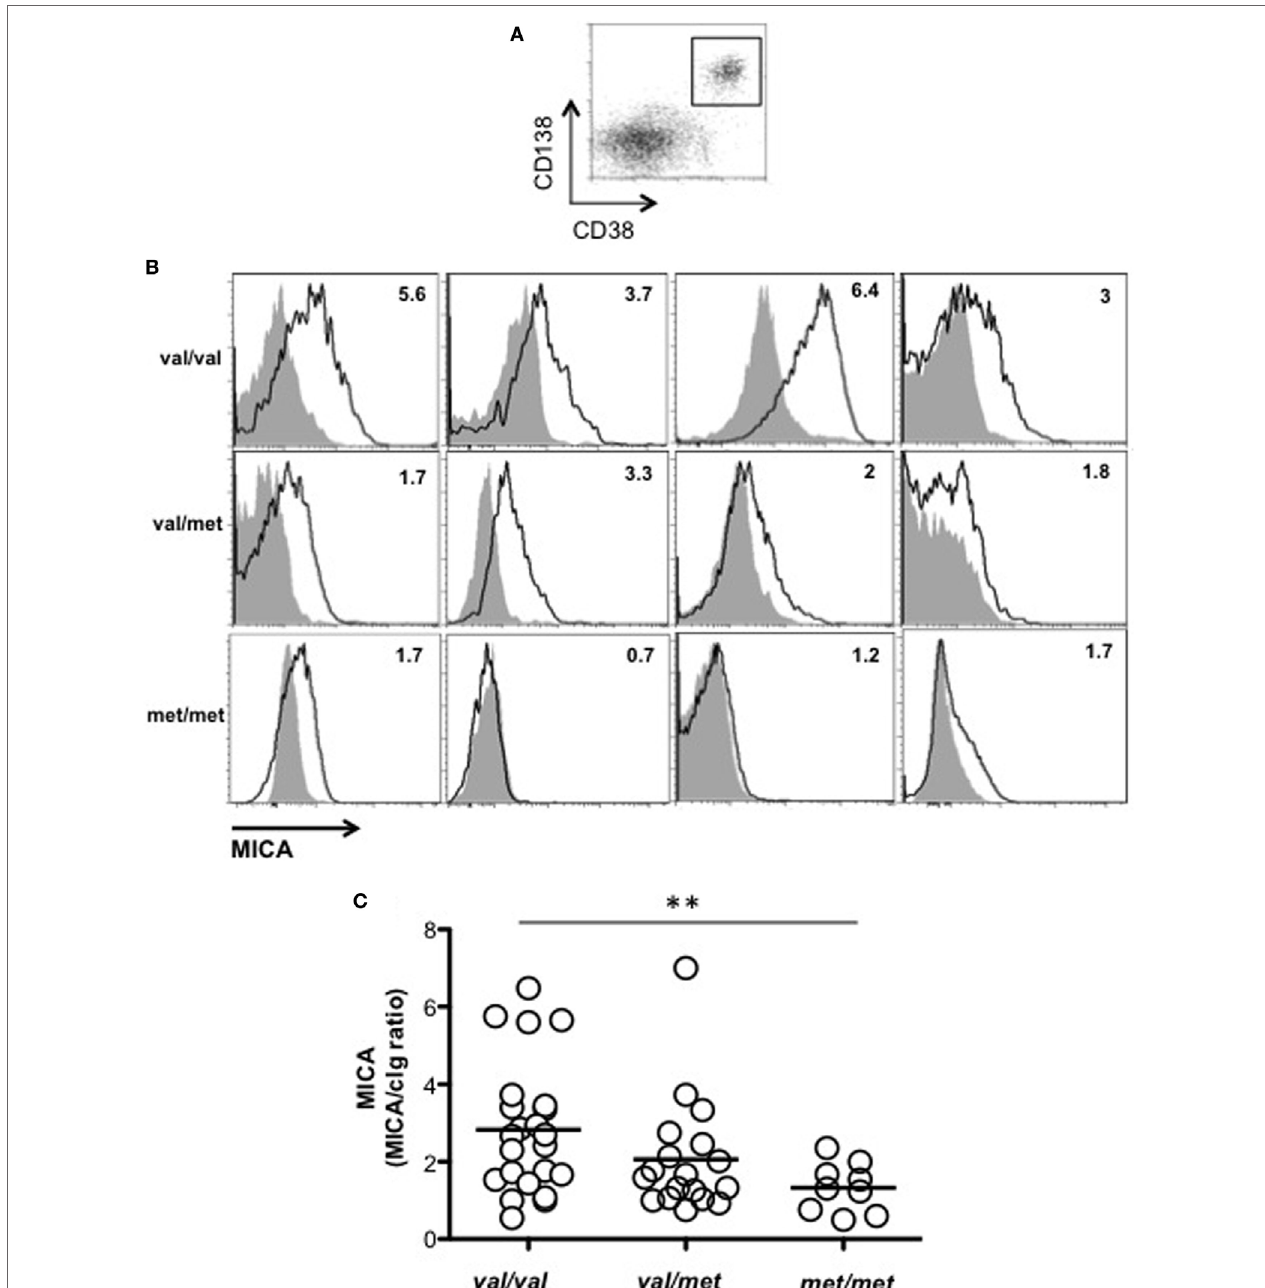
FigUre 3 | MICA cell-surface expression on malignant plasma cells (PCs) resulted higher in MICA-129Val/Val patients. Total cells derived from the bone marrow (BM) of patients at different disease states were stained with isotypic cIg or anti-MICA together with anti-CD38 and anti-CD138 mAbs. (a) MICA expression was analyzed by gating CD38 + /CD138 + cells. (B) Representative histograms of different patients are reported. Values indicated in each histogram represent the ratio between the MFI value of MICA divided by the MFI value of the isotypic cIg. Solid gray histogram: cIg; black line: MICA. (c) Total number of patients analyzed, n = 50 (Val/Val = 23, Val/Met n = 18, Met/Met = 9) that were smoldering ( n = 10), onset ( n = 19), and relapse ( n = 21). Abbreviations: Val, valine; Met,